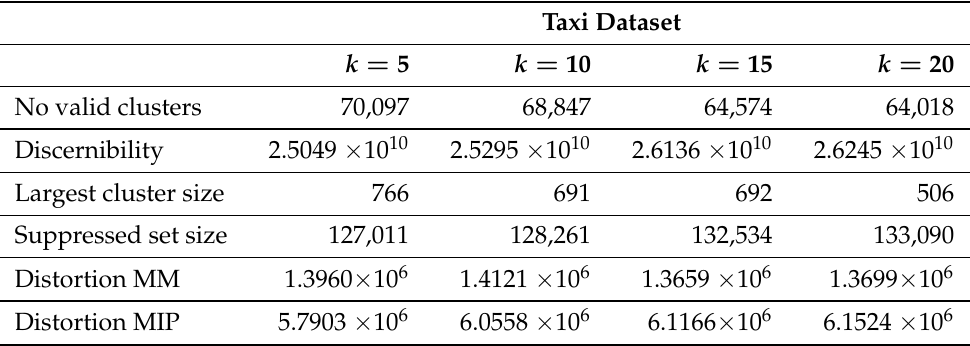
Table 2. Study of discernibility and distortion with a varying k on the taxi